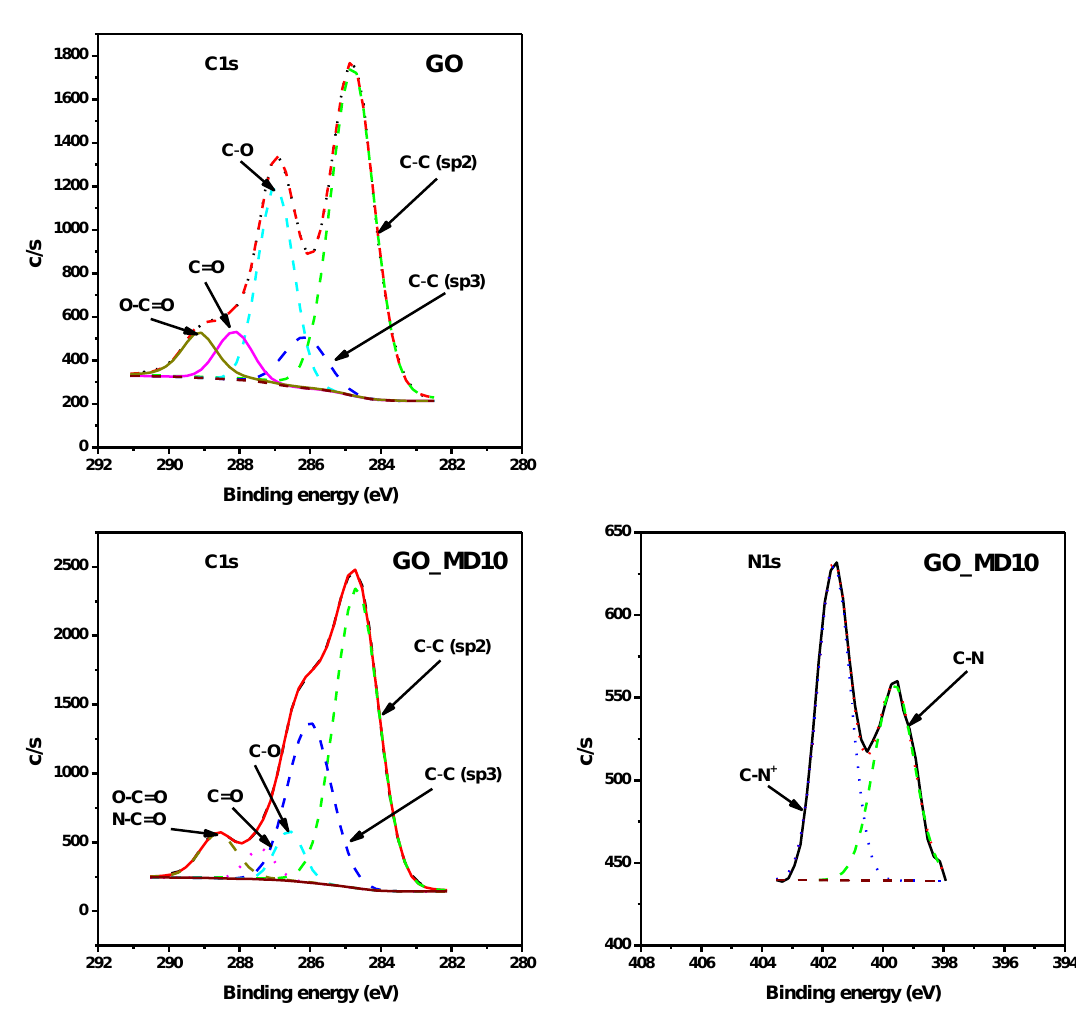
Figure 7. C1s and N1s XPS spectra of GR and GR_MD10.